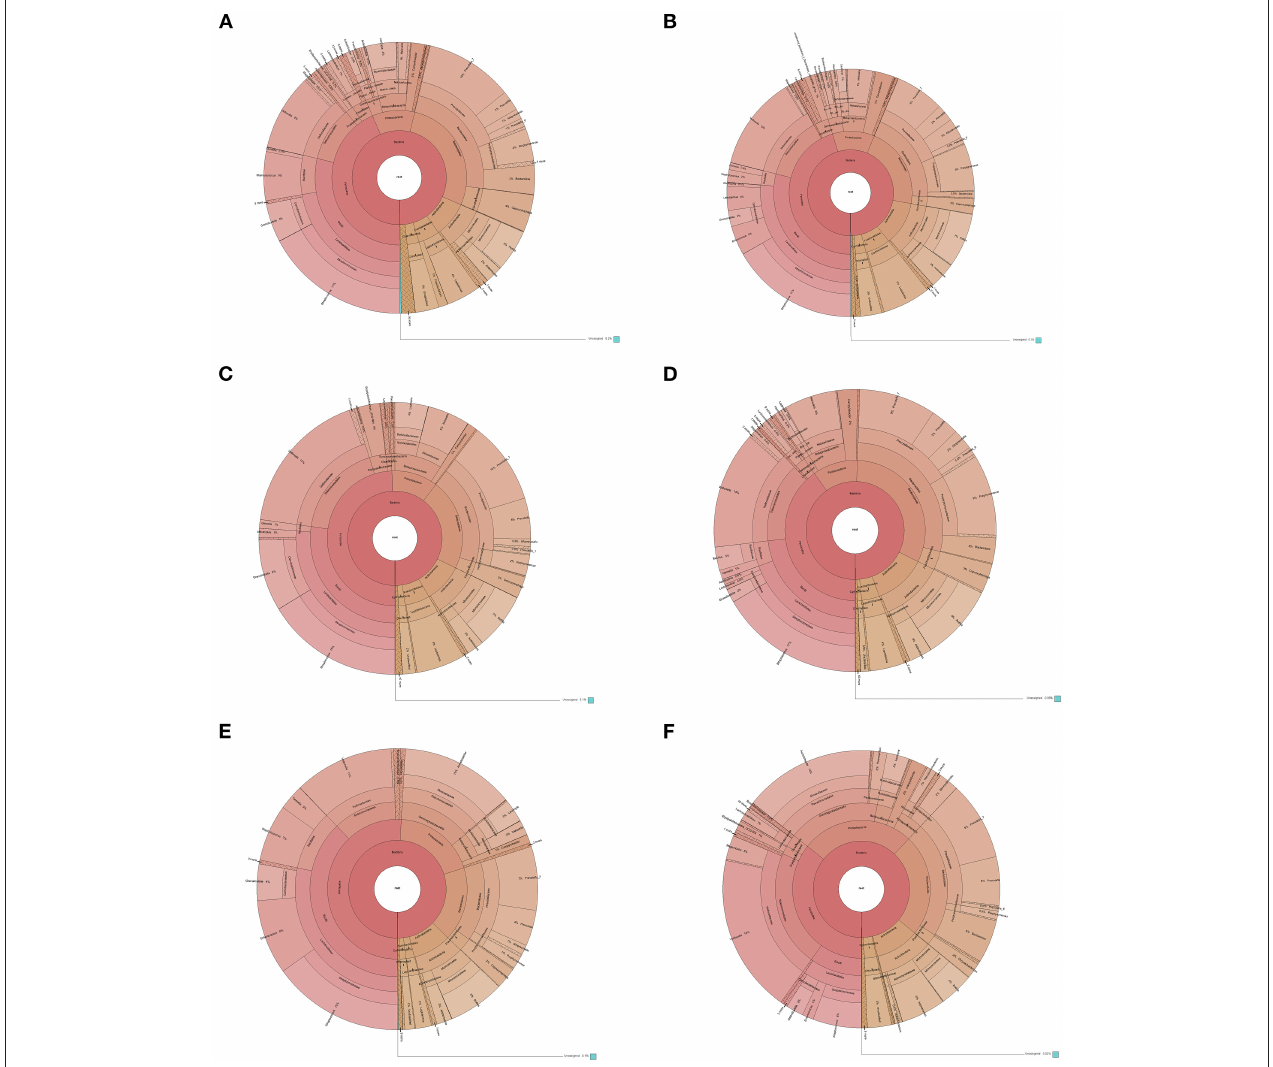
FIGURE 1 | Species distribution of each group. Krona is taxonomy web visualization; circles from inside to outside represent different classification levels, and the area of the sector indicates the proportion of different OTU annotation results. Rings from inside to outside: Contents of various bacteria at the kingdom, phylum, class, order, family, and genus levels. (A) : ICS 1 day. (B) : SCS 1 day. (C) : ICS 7 day. (D) : SCS 7 day. (E) : ICS 14 day. (F) : SCS 14 day.